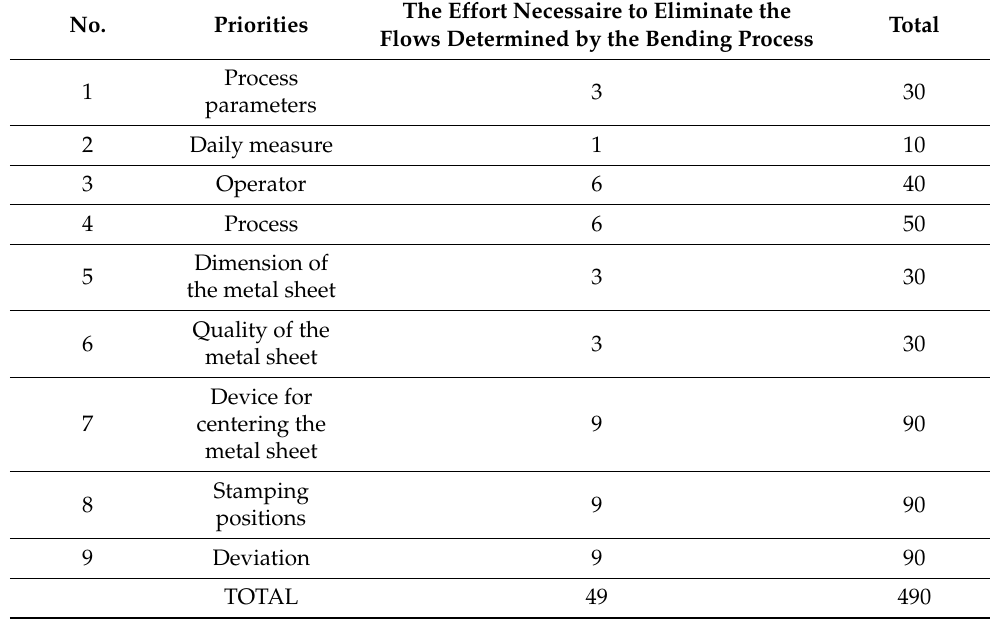
Table 3. Priority matrix.